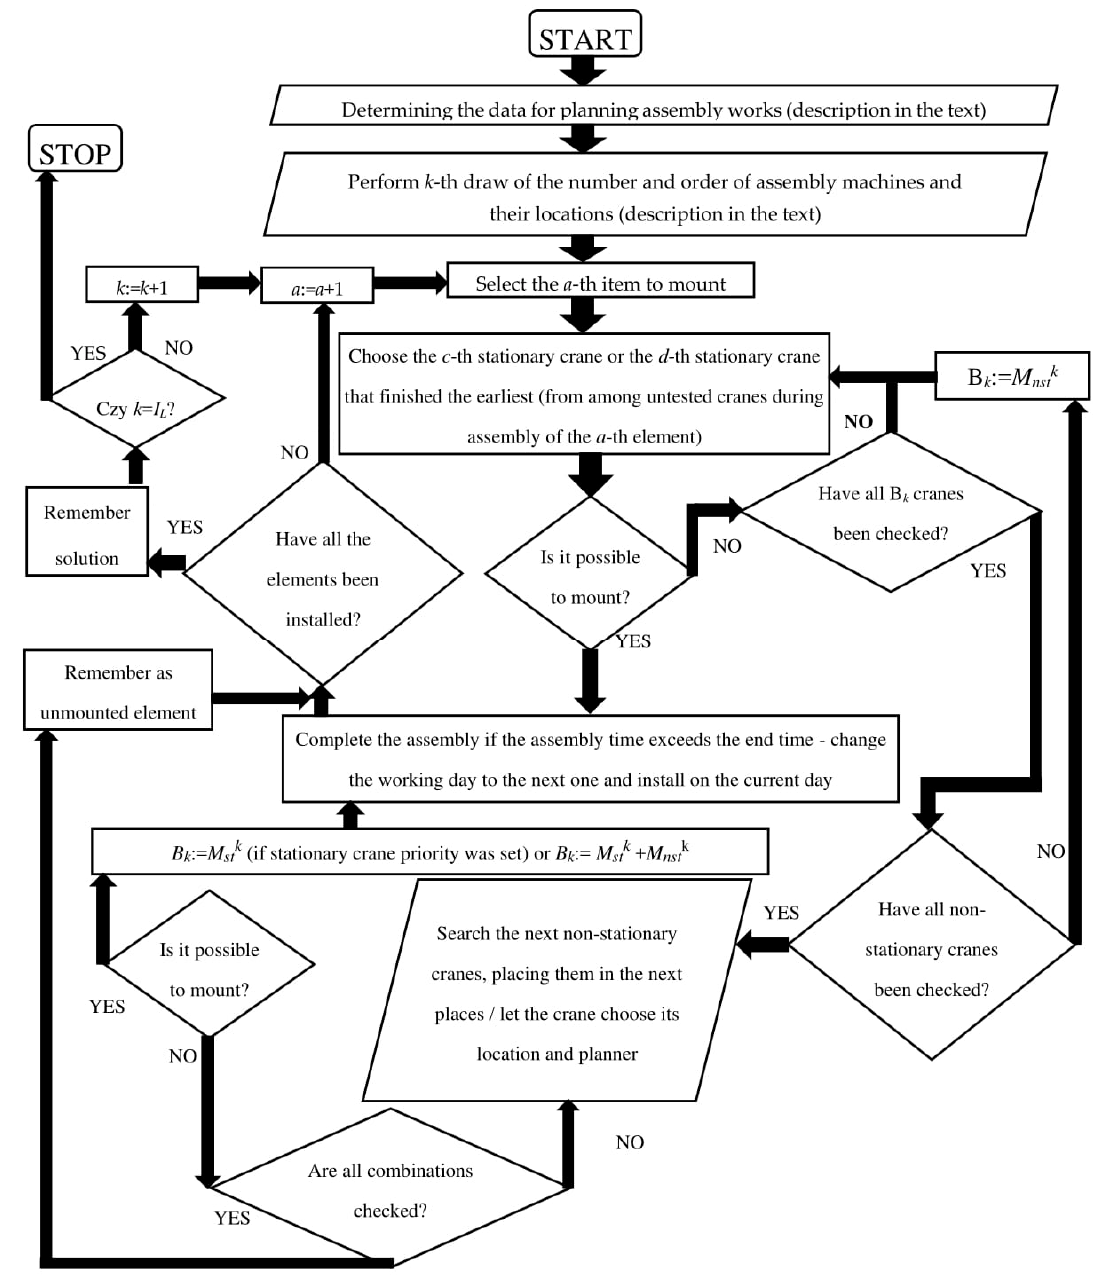
Figure 1. A block diagram of the assembly planning system. Sourced from our own study.